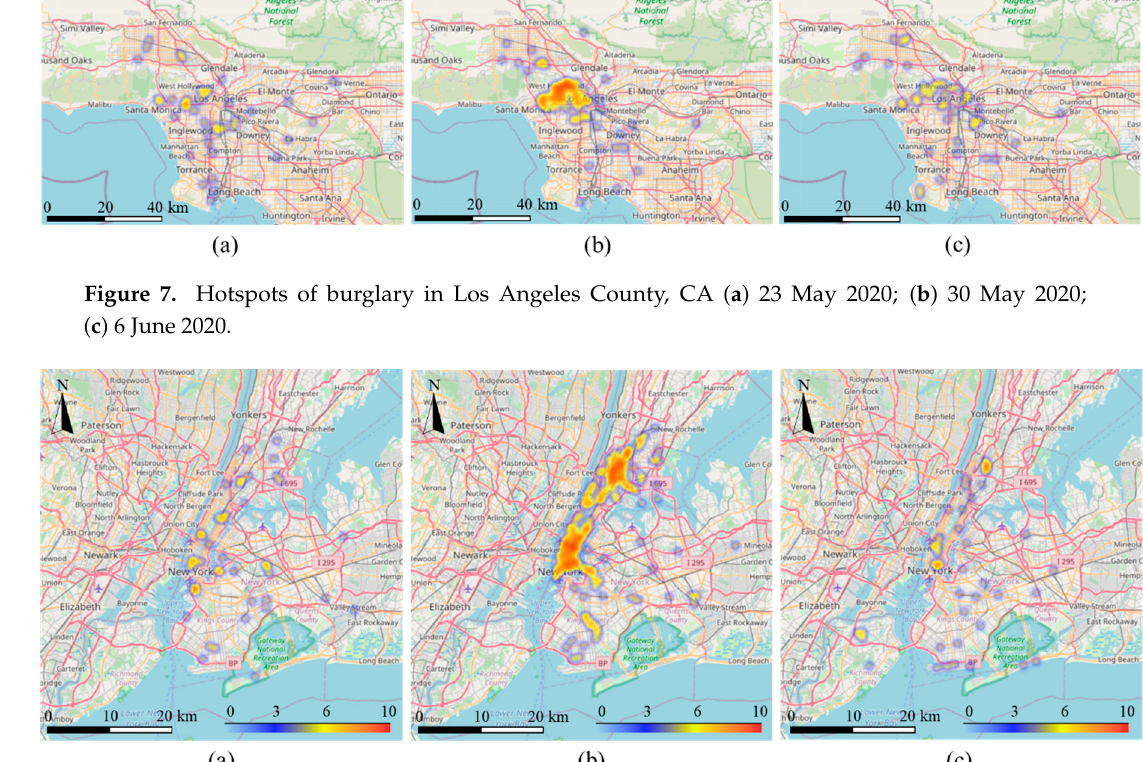
Figure 9. Hotspots of burglary in Chicago, IL ( a ) 24 May 2020; ( b ) 31 May 2020; ( c ) 7 June 2020.